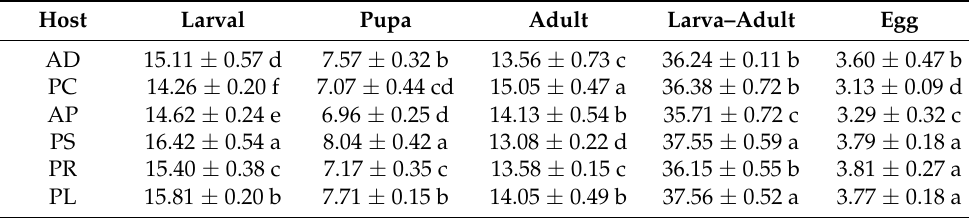
Egg indicates the egg stage of first generation. Means in the same row followed by different lowercase letters differed significantly ( p <